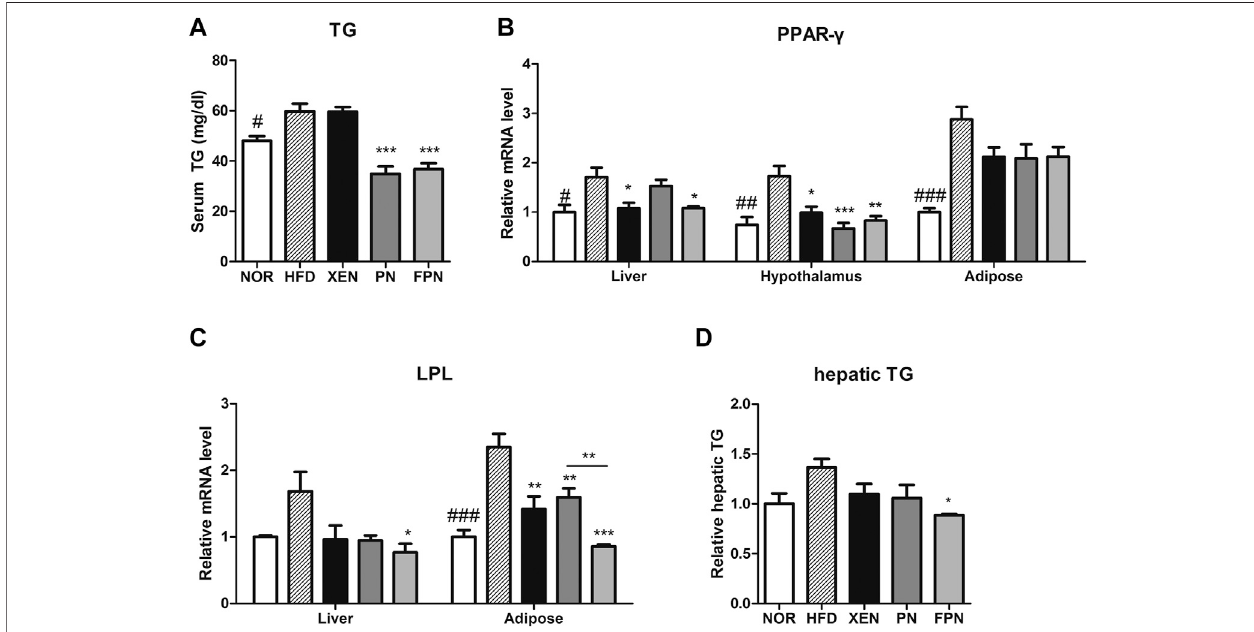
FIGURE 4 | Effect of PN and FPN on the lipid metabolism of HFD-induced mouse model after treatment for 9 weeks. The TG was measured in (A) serum and (D) liver.Theexpressionofthegenesofinterestintheliver,hypothalamus,andadiposetissuewasdeterminedbyRT-PCR.Therelativegeneexpressionsof (B) PPAR- γ and (C) LPL which play an important role in lipid metabolism were measured. The data are expressed as the mean ± SEM ( n (cid:2) 7 – 8); # p < 0.05; ### p < 0.001; NOR vs. HFD group. * p < 0.05; ** p < 0.01; *** p < 0.001; HFD group vs. treatment groups (XEN, PN and FPN).